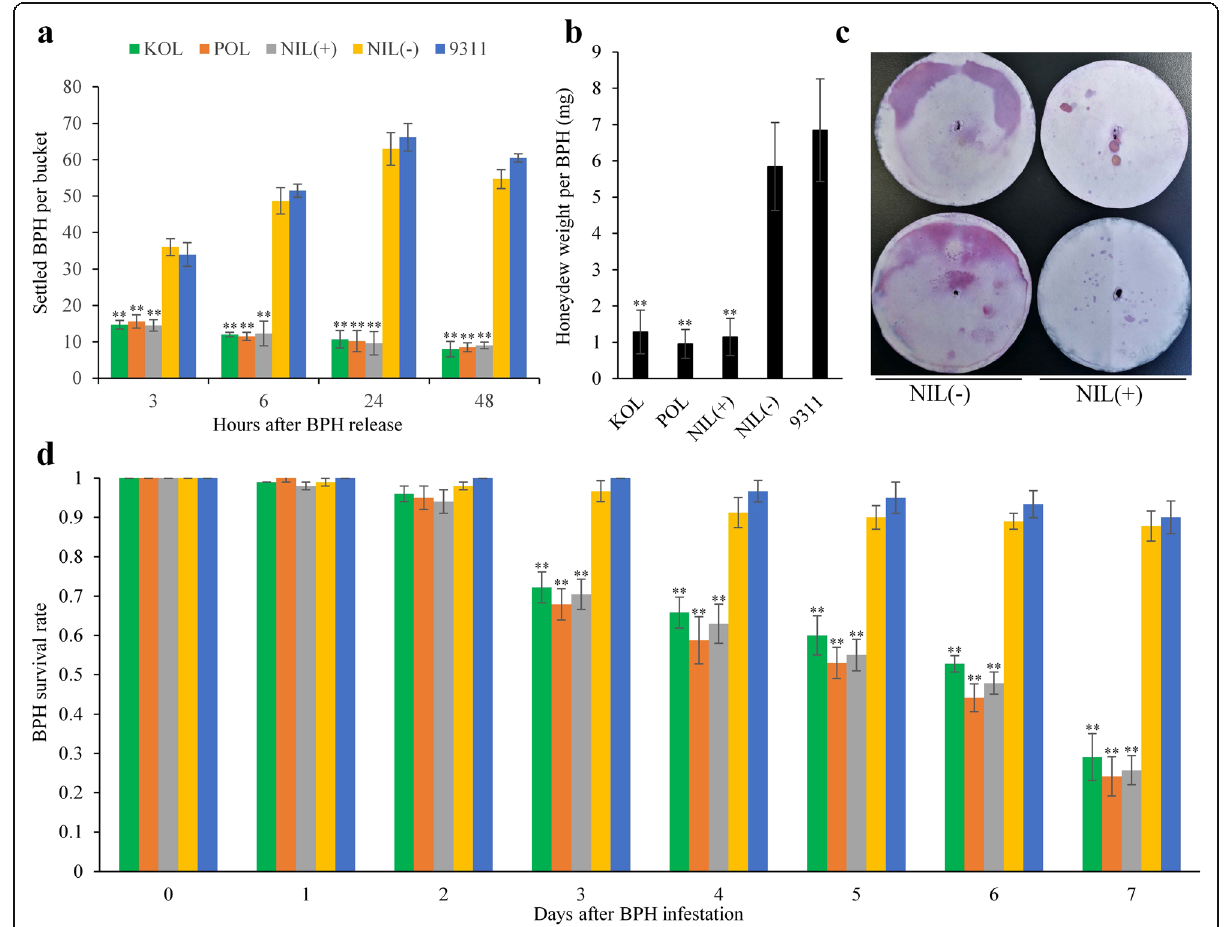
Fig. 6 Tests of antixenosis and antibiosis conferred by Bph33 . a BPH settlement preference on plants of different Bph33 genotypes. b Weights of honeydew secreted by BPH on NILs and parents. c Areas of honeydew secreted by BPH feeding on NIL(+) and NIL( − ) plants. d Survival rates of BPH on NILs and parents. The column colors have the same meanings as in a . KOL, KOLAYLA; POL, POLIYAL. Asterisks indicate significant difference between the resistant and the susceptible genotypes at 0.01 level. Error bar indicates standard